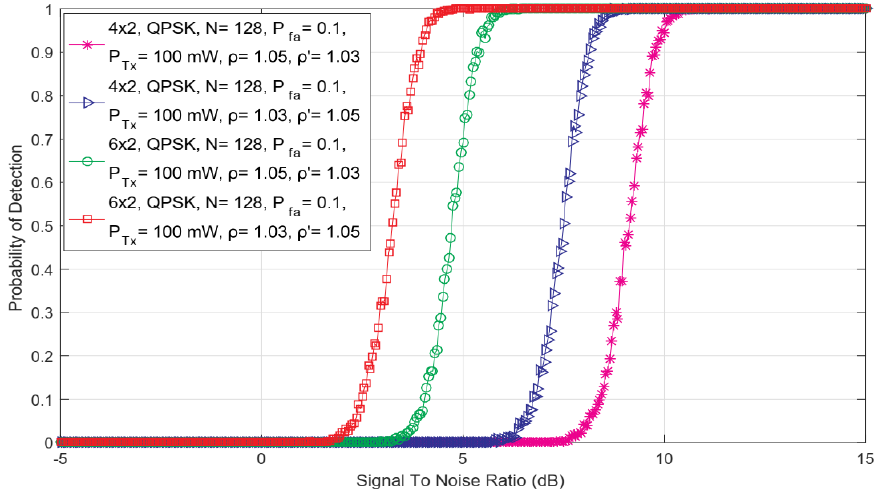
Figure 6. The dependency of detection probability on SNR for ED performed with different combinations of DDT and NU factors in asymmetric communication MIMO 4 × 6 and 6 × 4 systems.